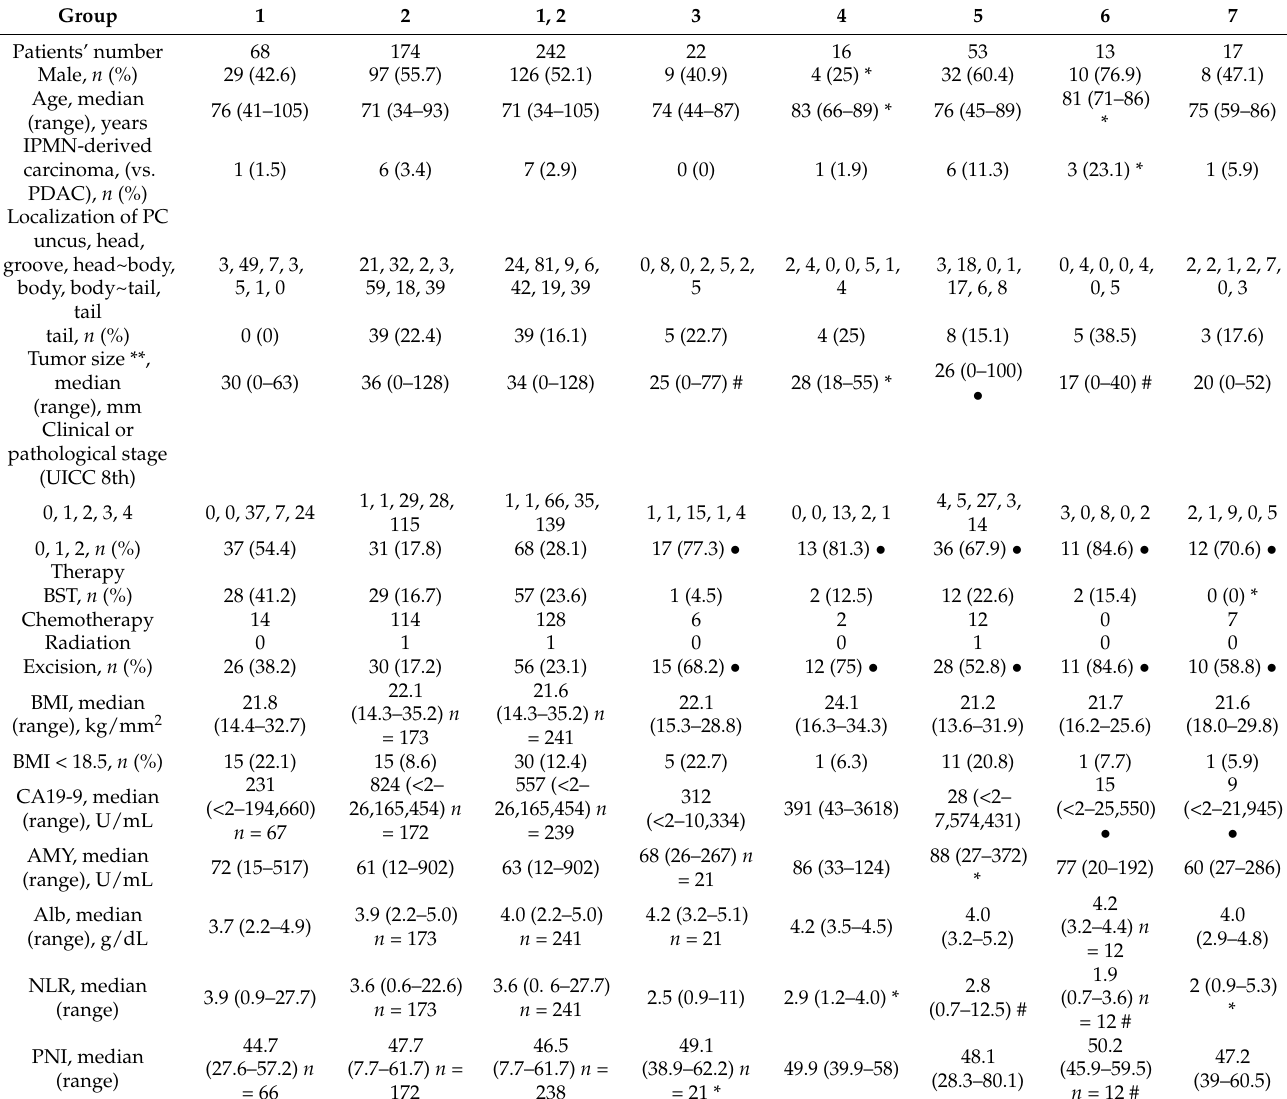
Table 2. Patient’s characteristics in each